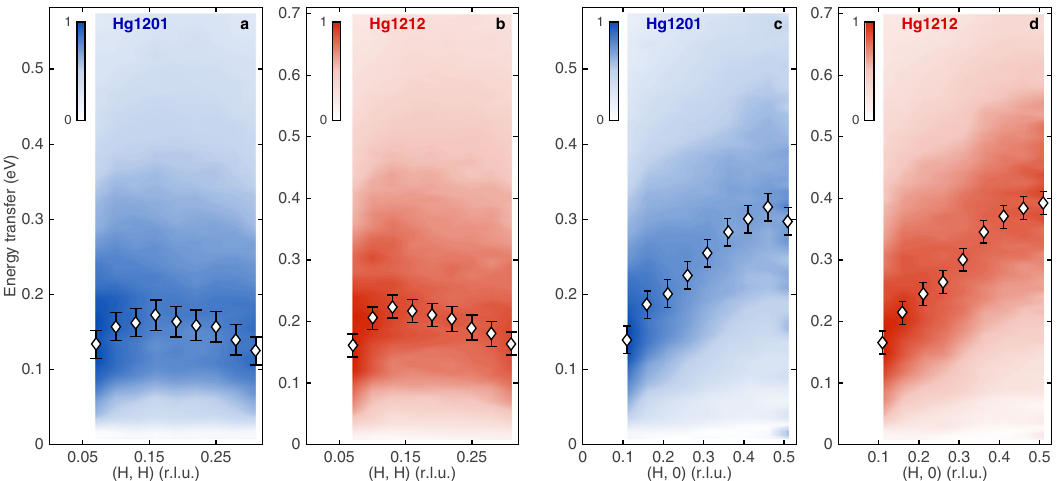
Fig. 2 Comparison of paramagnons in Hg1201 and Hg1212. a , b False-color representation of energy- and momentum-dependent RIXS intensities arising from paramagnons in Hg1201 and Hg1212, respectively, along the ( H , H ) momentum direction. The signal is extracted from the data displayed in Fig. 1d, h, after subtracting the non-magnetic contributions and normalizing the energy-integrated spectral weight among different Q // . Diamond symbols indicate energy positions of intensity maxima (according to the DHO fi ts in Fig. 1) at the measured Q // , with values and error bars identical to those in Fig. 1. c , d Same as a , b , but for the ( H , 0) momentum direction. For visual comparison between the two systems, the vertical energy scales of b and d are set to be 130% of those of a and c